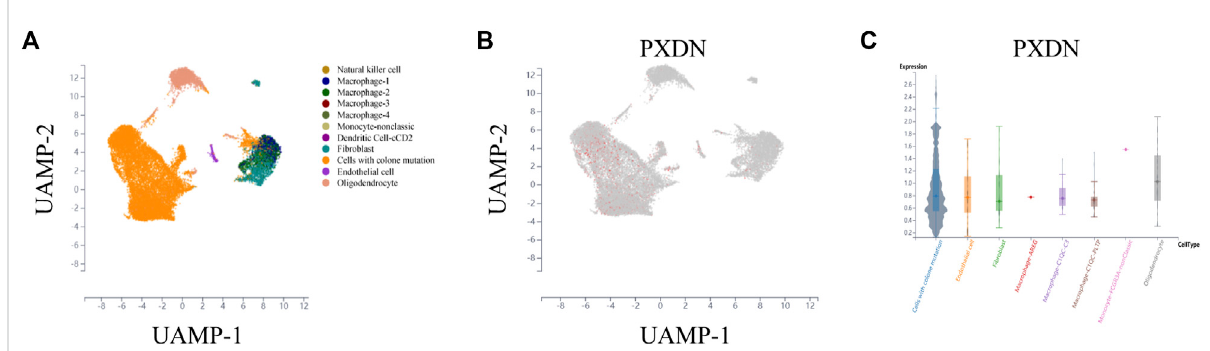
FIGURE 2 Single-cellsequencinganalysistodetectthecelllocalizationofPXDN. (A) AllcellsinGBMsampleswereclusteredinto11clusters. (B) PXDNwas mainly enriched in the cell cluster with colone mutation. (C) Violin diagram showing the PXDN expression in different cell clusters.